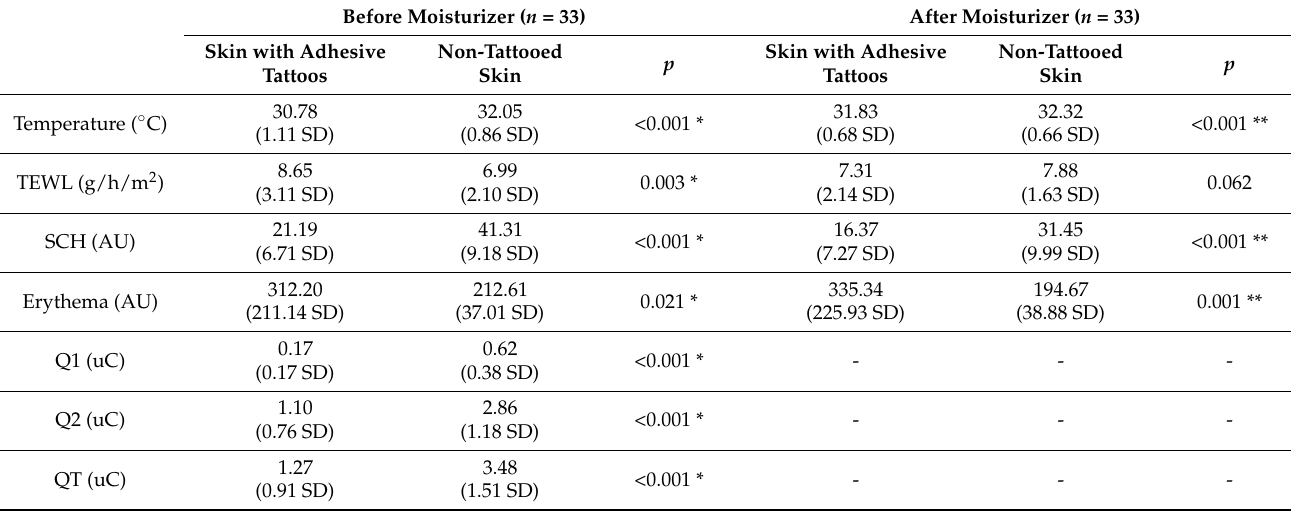
Table 3. Differences in biophysical parameters between skin with adhesive tattoos and non-tattooed skin. Before Moisturizer ( n = 33)